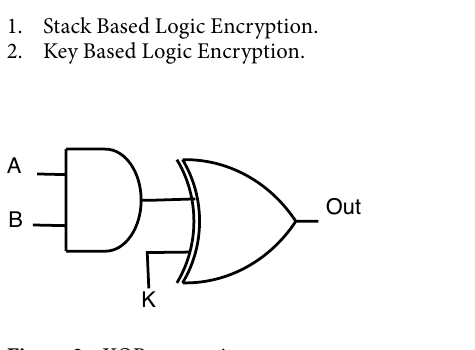
Figure 3. XOR encryption.